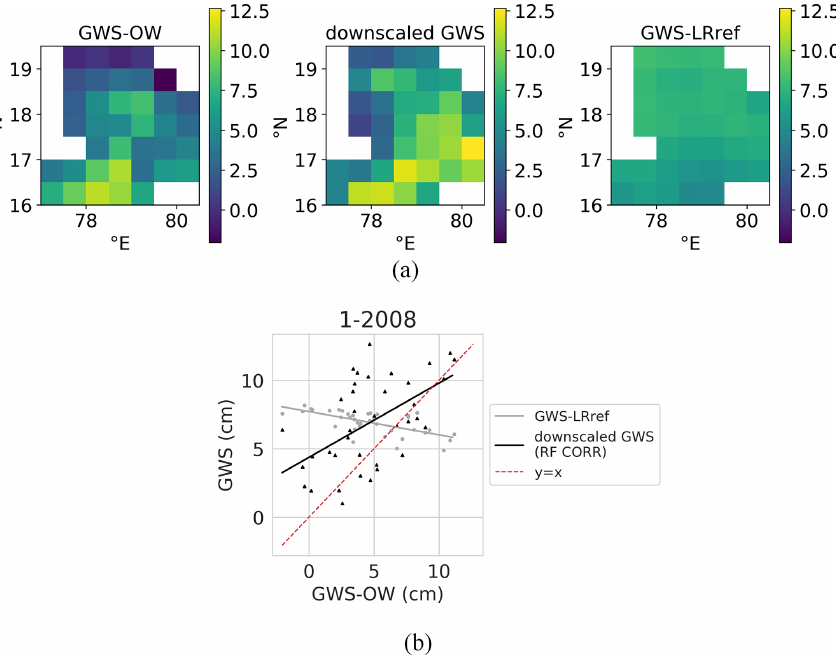
Figure 6. Illustration of the spatial gain for the month of January 2008. (a) Maps of HR in situ derived GWS (GWS-OW), RF CORR- downscaled GWS, and LR reference GWS (GWS-LRref). The abscissa is the east longitude and the ordinate the north latitude. (b) Scatterplot of the GWS-LRref (grey points) and RF-downscaled GWS (black points) against GWS-OW. The identity function is indicated by a dashed red line. The slope of the two linear regression fits on grey and black points are used to compute the gain in the slope. The differences in dispersion, uncertainty, and bias of the two point clouds are evaluated with gains in R , RMSE, and mean